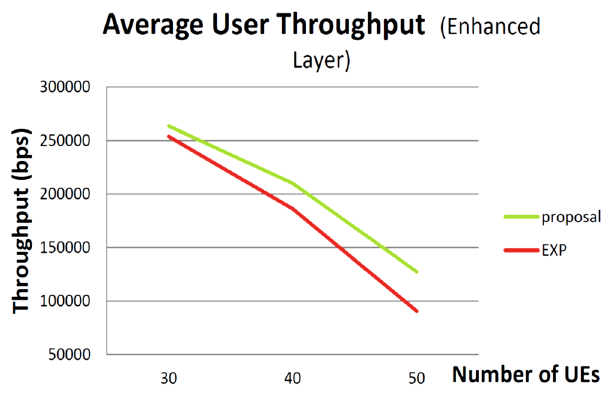
Figure 12. Average user throughput (UE velocity = 120 km/h).